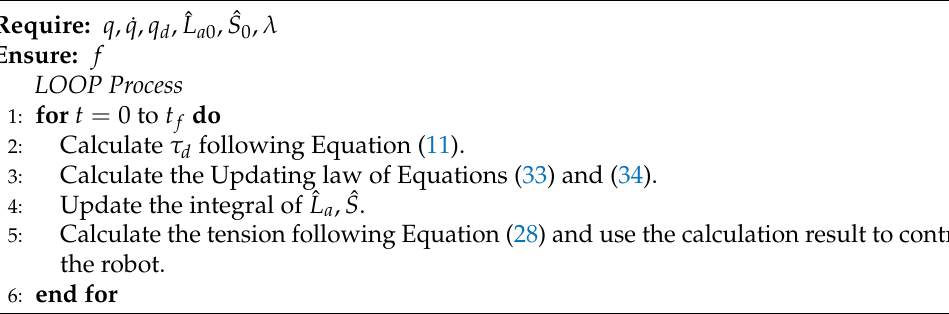
Figure 2. Relation between wrench space and tension space. Algorithm 1 tanh(:)-based Optimal Tension